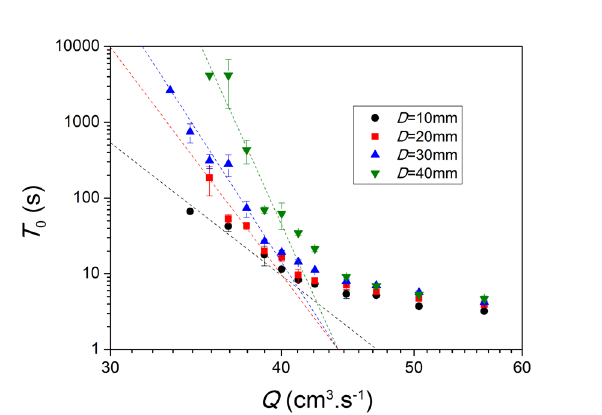
Figure 4. Log-log representation of the transient duration T 0 versus injection flow rate Q for d = 3 mm , H 0 = 125 mm , and for D = 10 mm , D = 20 mm , D = 30 mm , and D = 40 mm , respec- tively. The dashed lines are only guides for the eyes suggesting a linear relation between ln T 0 and ln Q